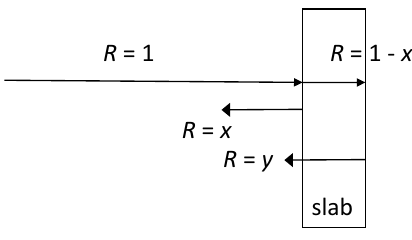
Figure 6. Schematic illustration of normalised Fresnel reflections from the front and back faces of the slabs, where x = y/(1 − x) if reflection is assumed identical at both faces. Differences in expected intensity are represented by x and y.